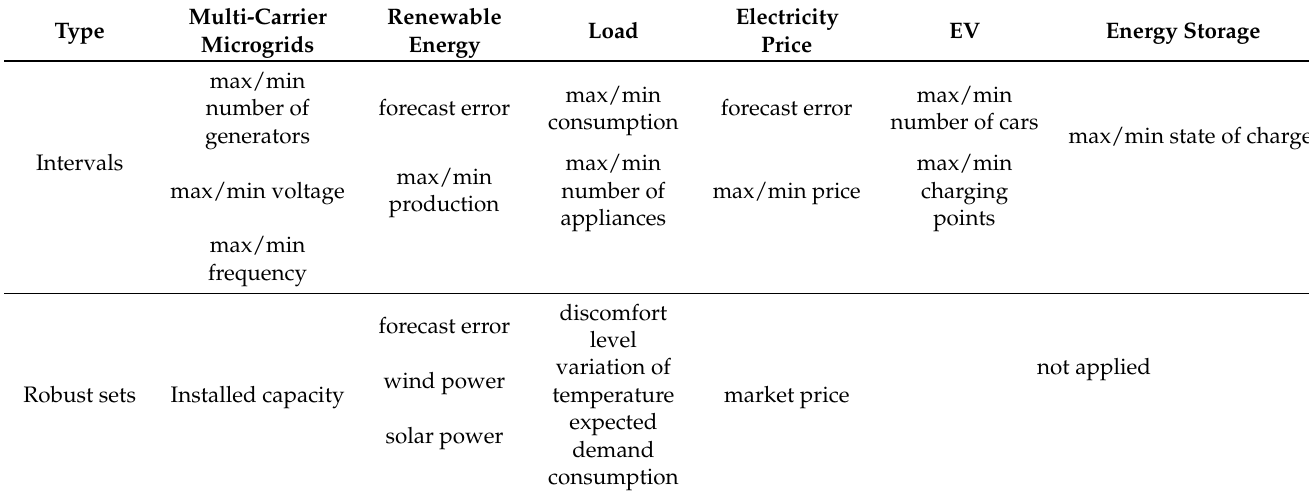
Table 6. Main characteristics and applications of deterministic